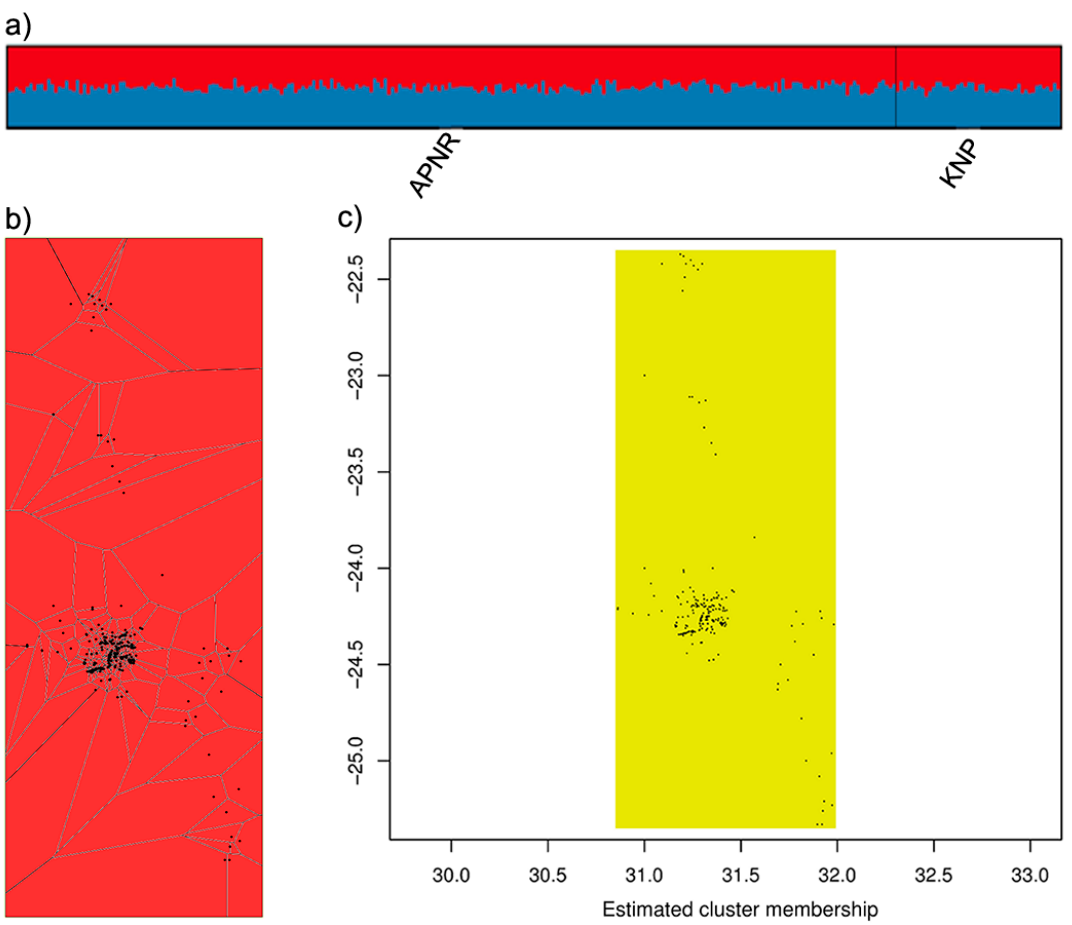
Figure 4. Bayesian clustering results for all individuals in the APNR and KNP. ( a ) Bar plot from S tructure when K = 2. Each individual is depicted by a column that is partitioned into K segments, which length is proportional to the membership coe ffi cient of the individual for each cluster. A vertical black line separates individuals from the two areas, which are labelled below the figure. ( b ) Voronoi tessellation map for the most supported K = 1 in the no-admixture model of T ess . ( c ) Map of estimated cluster membership for the most supported K = 1 under the uncorrelated allele frequency model in G eneland . The dots in ( b ) and ( c ) represent the sampling location of individuals. The exact G-test indicated significant ( α = 0.05) genetic di ff erentiation between APNR and KNP in